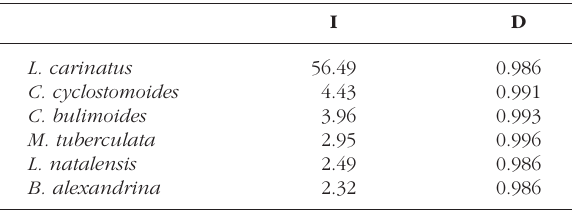
Table V. – Indices of aggregation of P. cantonensis in infected fresh- water